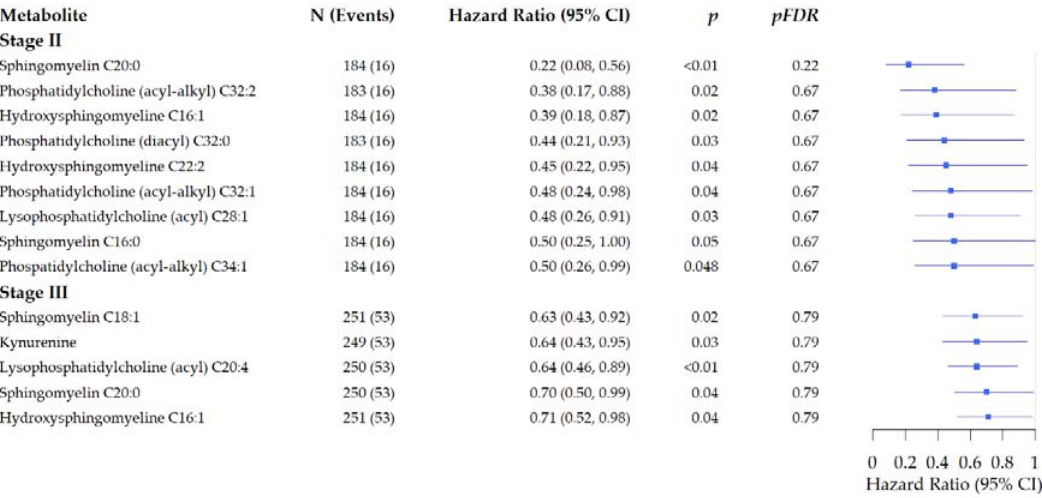
Figure 5. Forest plots of the associations of pre-surgery metabolite concentrations with risk of recurrence stratified by tumor stage in prospectively followed colorectal cancer patients. Analysis are adjusted for age, sex, tumor site, BMI (kg/m 2 ), and study cohort. (Hazard ratio and 95% Confidence